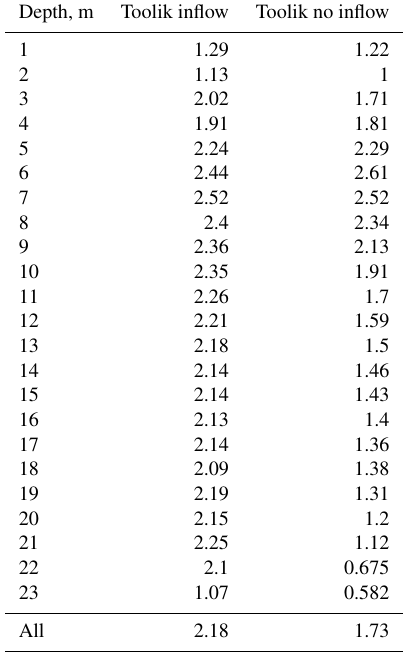
Table B1. Toolik model lake temperature error (RMSE) for inflow and no inflow simulations.